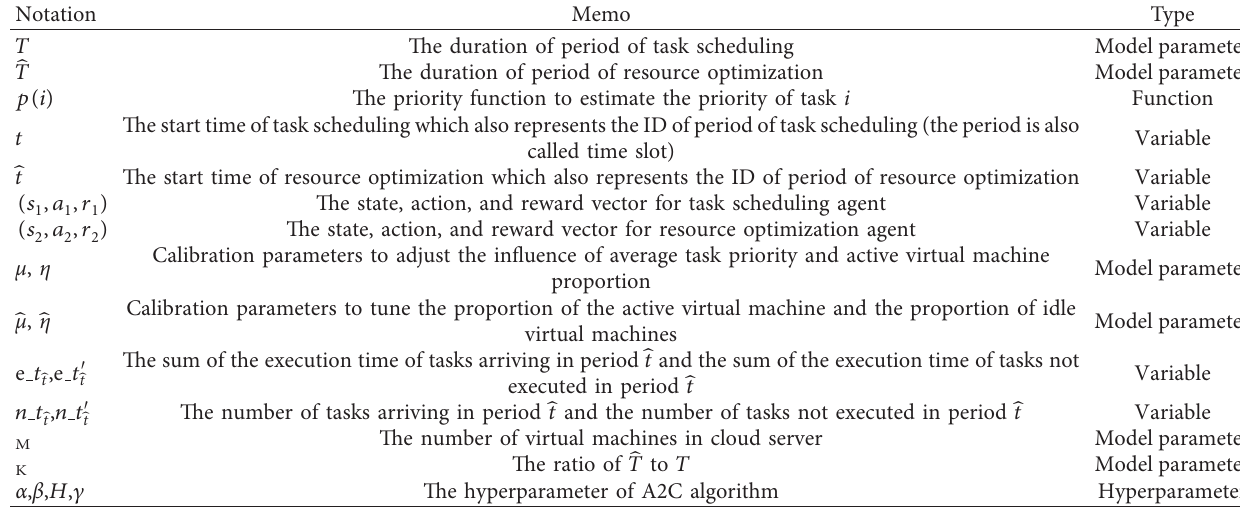
Table 1: Notations in the scheduling system